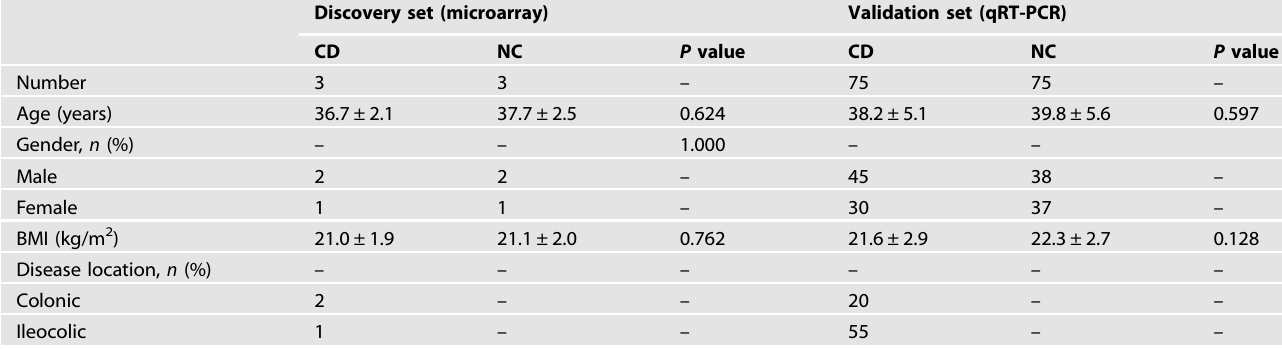
Table 1. Patient demographics for the